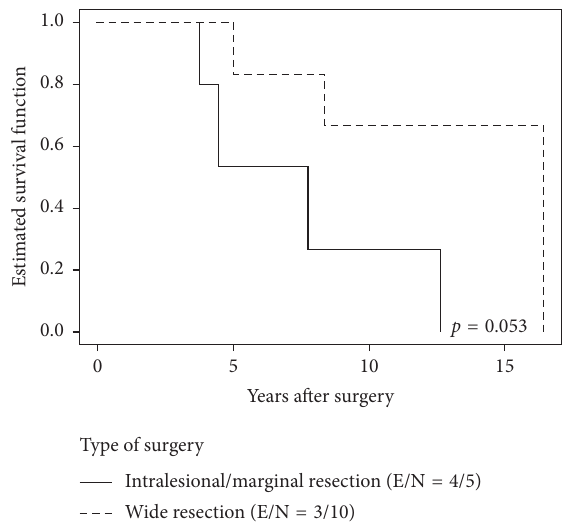
Figure 3: Recurrence-free disease-specific survival by the type of resection performed. There was a significant association between wide resection and longer recurrence-free